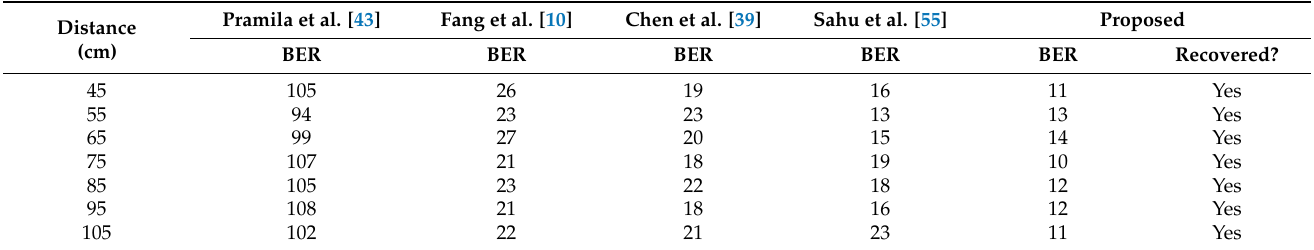
Table 5. BER values for the extracted watermark at different capturing distances.